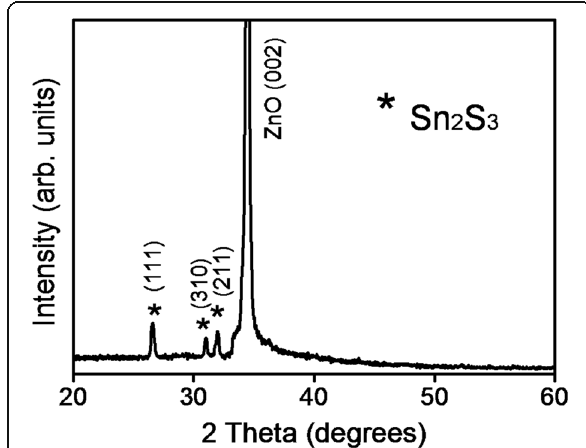
Fig. 2 XRD pattern of ZnO – Sn 2 S 3